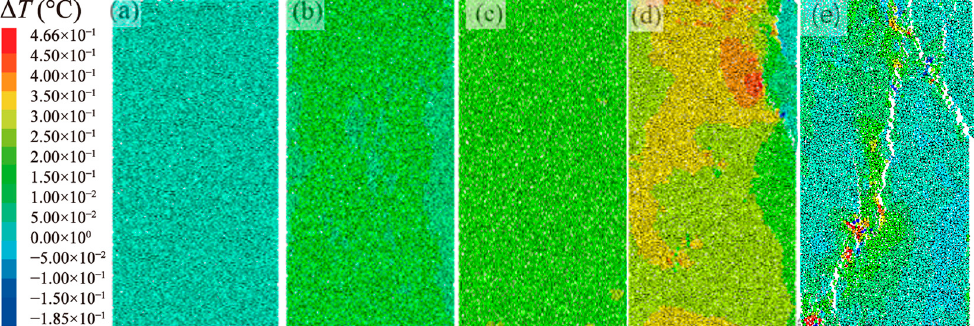
Figure 6. Particle temperature diagram of the numerical experiment at different stress levels ( a ) 0.1 σ c ; ( b ) 0.4 σ c ; ( c ) 0.8 σ c ; ( d ) σ c ; ( e ) 0.1 σ c .